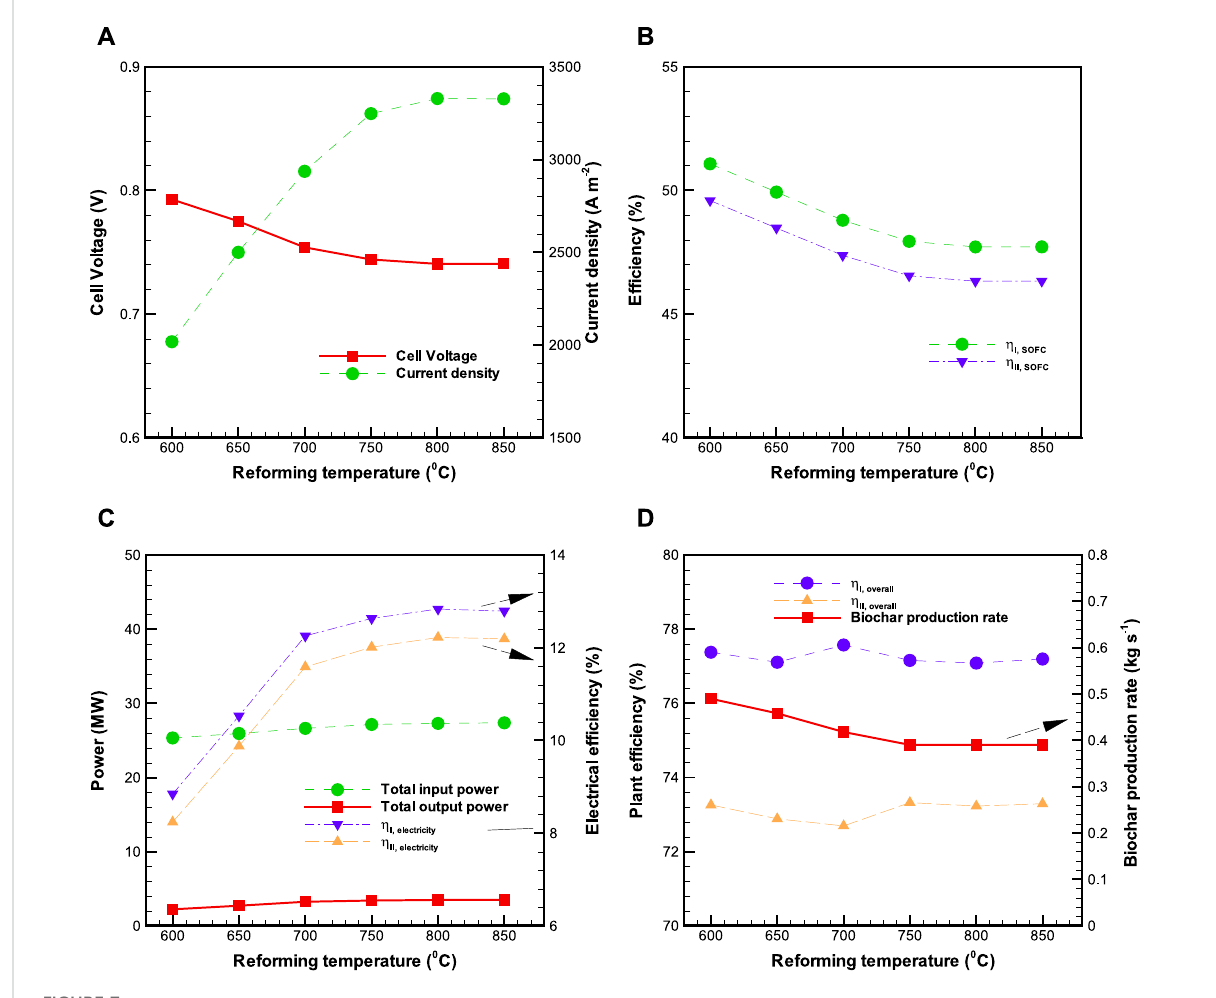
FIGURE 7 Effects of reforming temperature ( T reformer ) on the BP-SOFC-CHP system: (A) SOFC cell voltage and current density, (B) SOFC ef fi ciency, (C) total power input and output and electrical ef fi ciency, and (D) overall system ef fi ciency and biochar production rate.